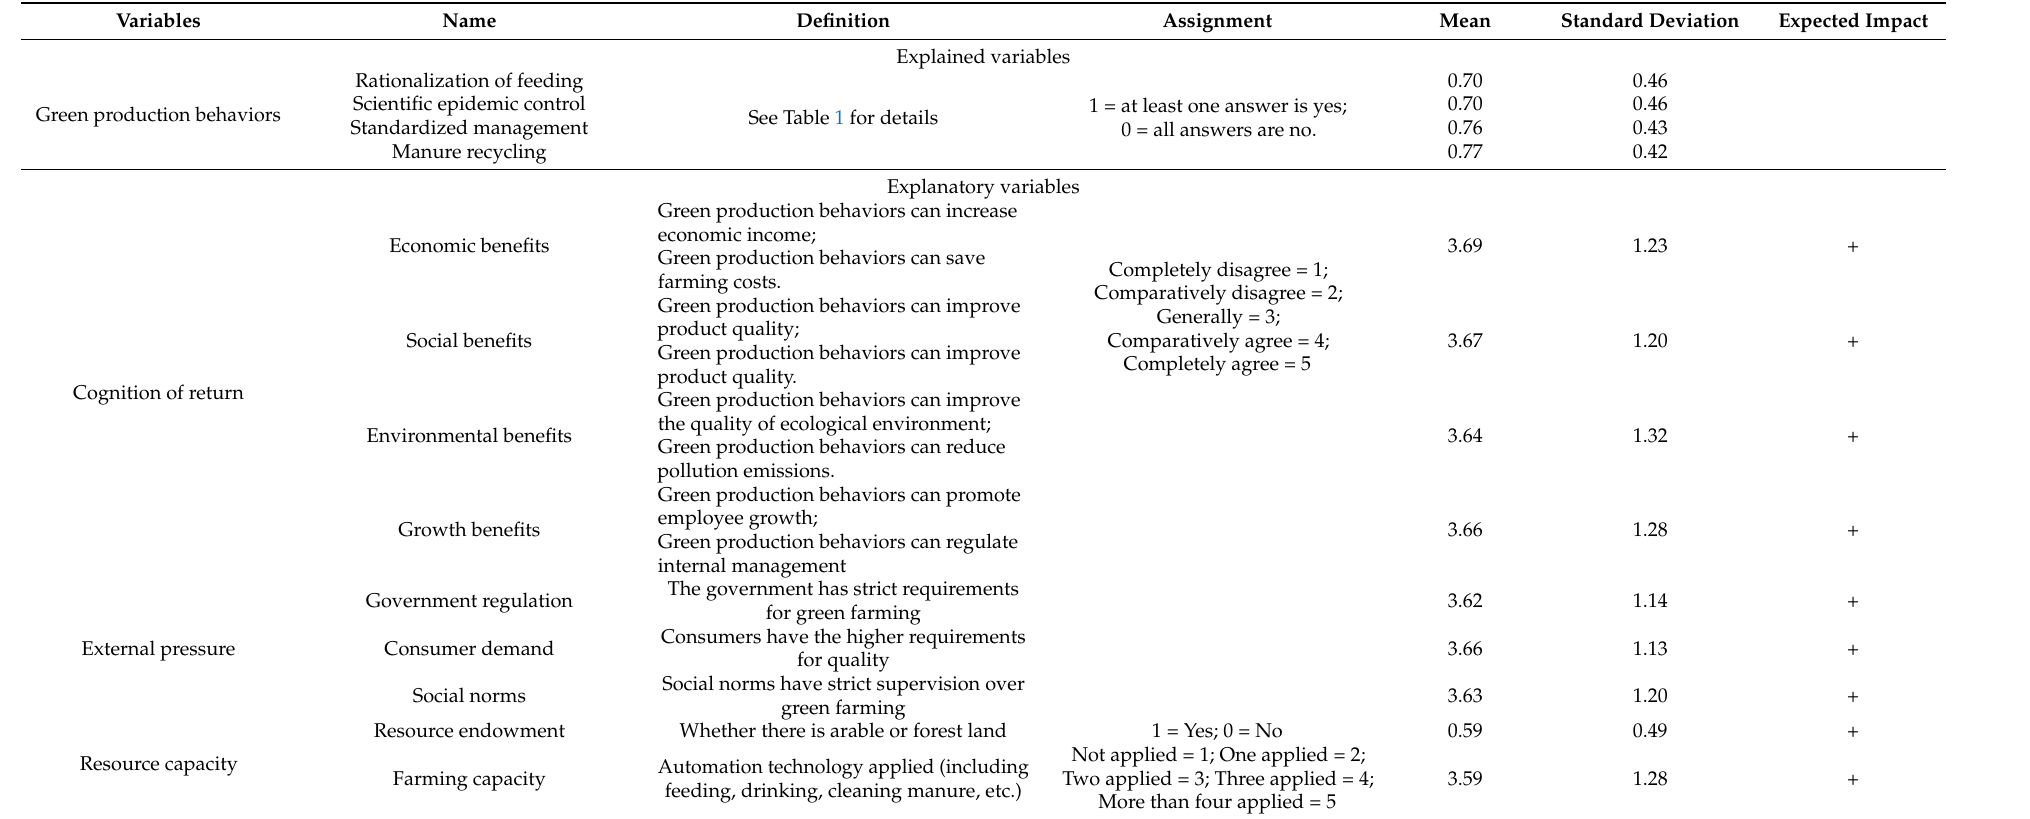
Table 2. Assignment and Description of